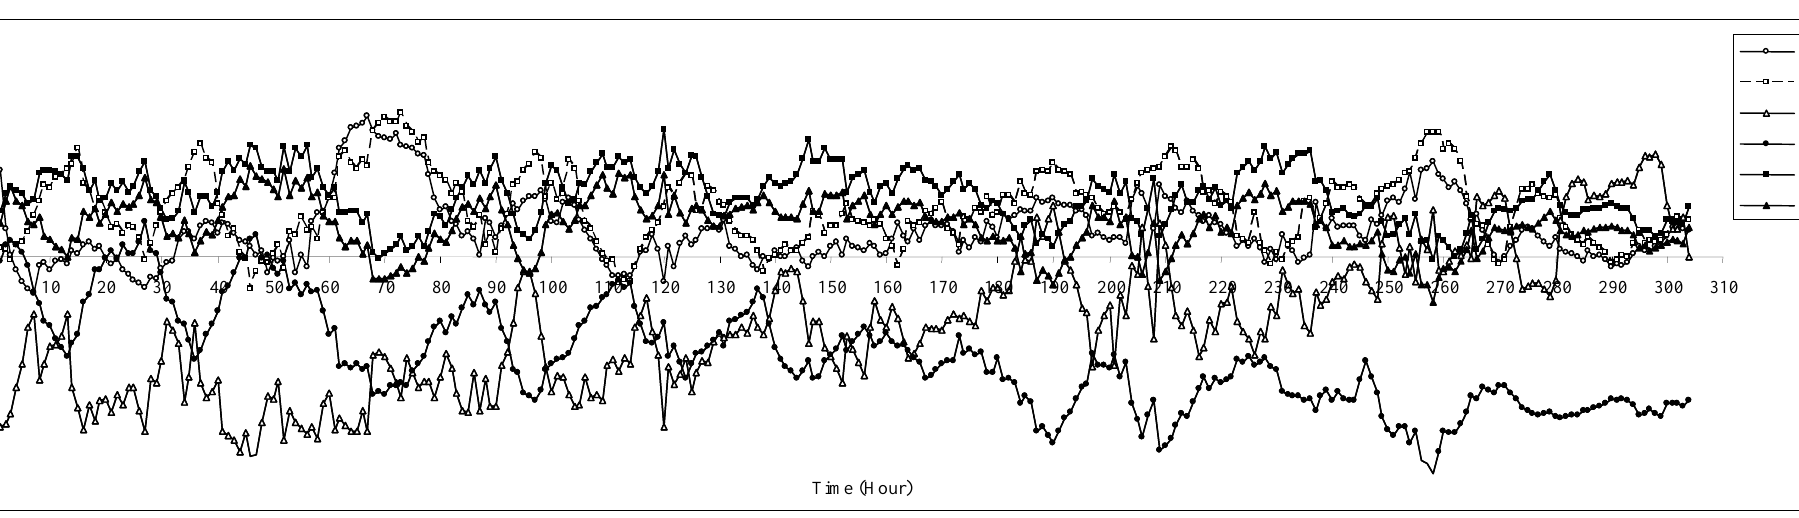
Figure 5. The temporal variation of percent deviation (PD) values derived using hourly mean value of CO